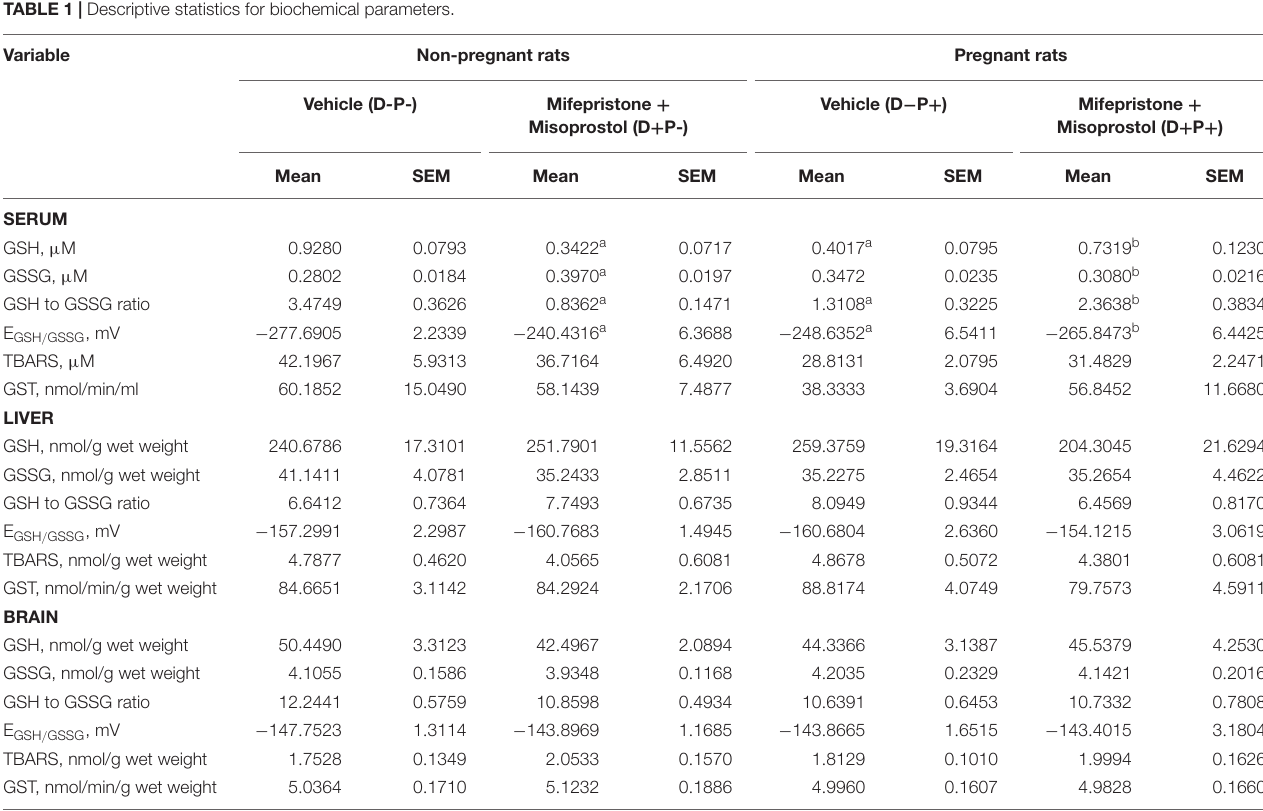
TABLE 1 | Descriptive statistics for biochemical